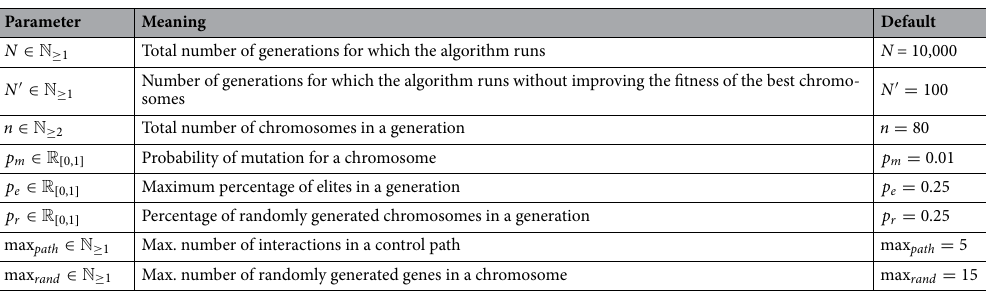
Table 3. The parameters used by the genetic